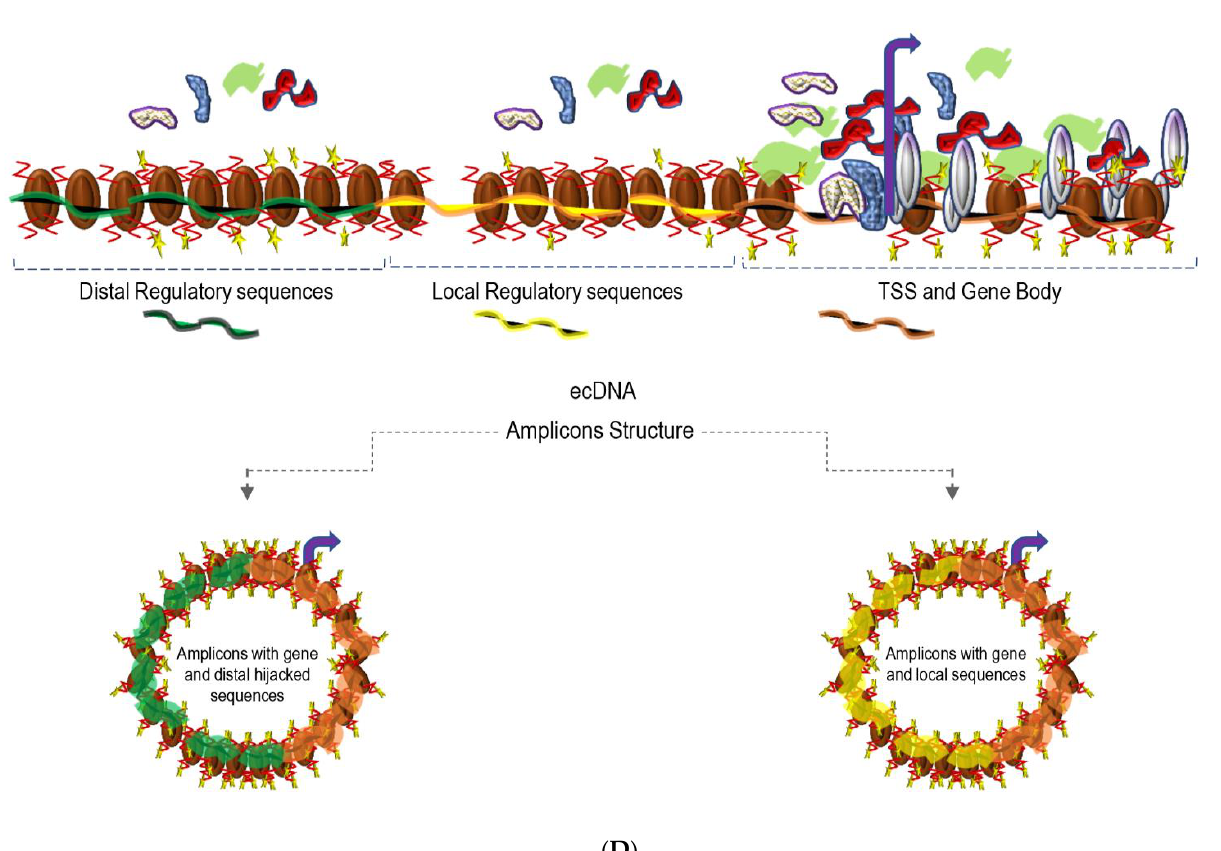
Figure 1. Diagrammatic illustrations of models of enhancers’ and SEs formation in normal and tu- mor cells: ( A ) Schemes and descriptions of Activators: e.g., MYB, GATA3, RUNX, etc.,